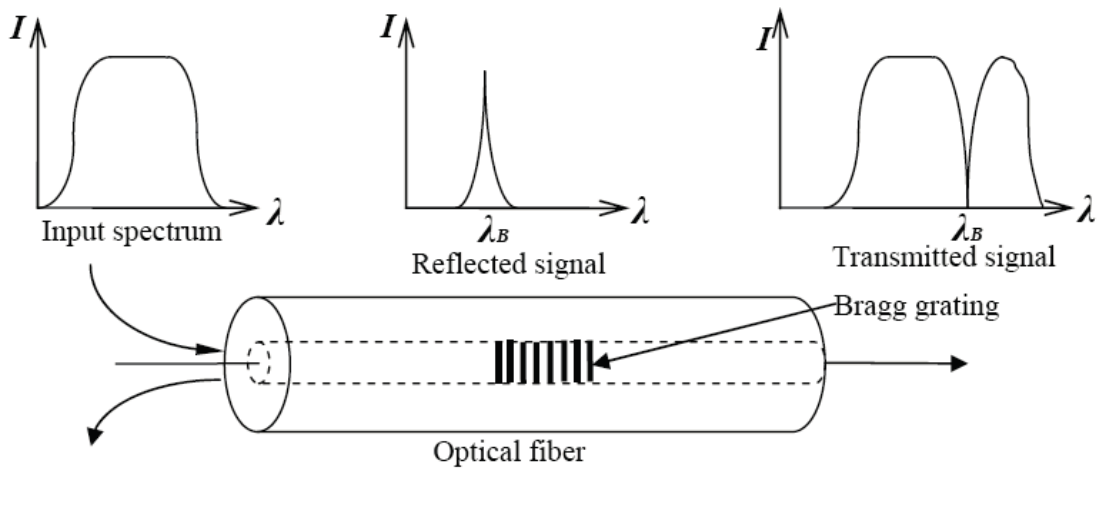
Figure 1. FBG sensor wavelength-encoding